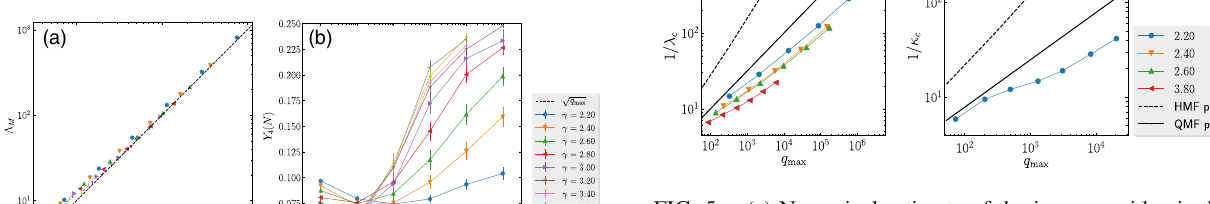
FIG. 5. (a) Numerical estimate of the inverse epidemic thresh- in LPA as a function of q , for various values of the old 1 = λ c max exponent γ . We consider networks of sizes from N ¼ 10 2 to ffiffiffiffiffiffiffiffiffi p q N ¼ 10 8 . (b) Numerical estimate of the synchronization thresh- in as a function of M max old κ for γ ¼ 2 . 2 as a function of q . System size ranges from c max N ¼ 300 to N ¼ 300 000 . In both plots the dependence for γ ¼ 2 . 2 predicted by the QMF theory is represented by a thick dashed straight line, and the HMF prediction is represented by a dash-dotted